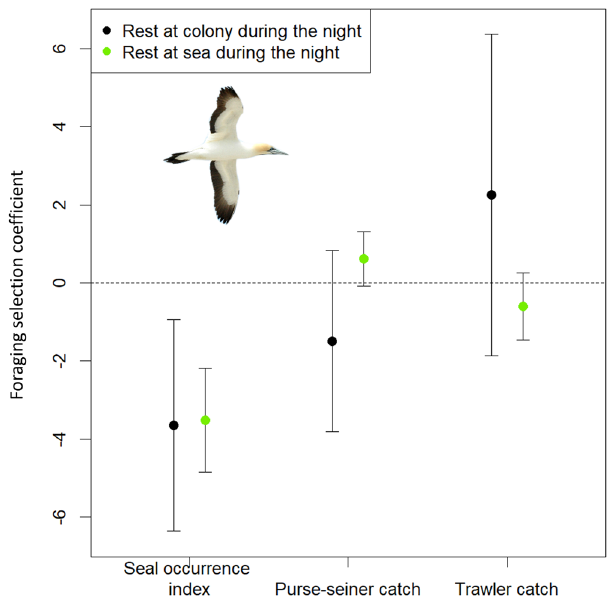
Fig. 2 Daytime foraging habitat selection of Cape gannets. Habitat selection coef fi cients of foraging behavior during daytime, depending on nighttime resting tactics for 197 Cape gannets from Malgas Island during October – November between 2008 and 2015. Error bars represent the 95% con fi dence interval. Con fi dence interval including 0 means no